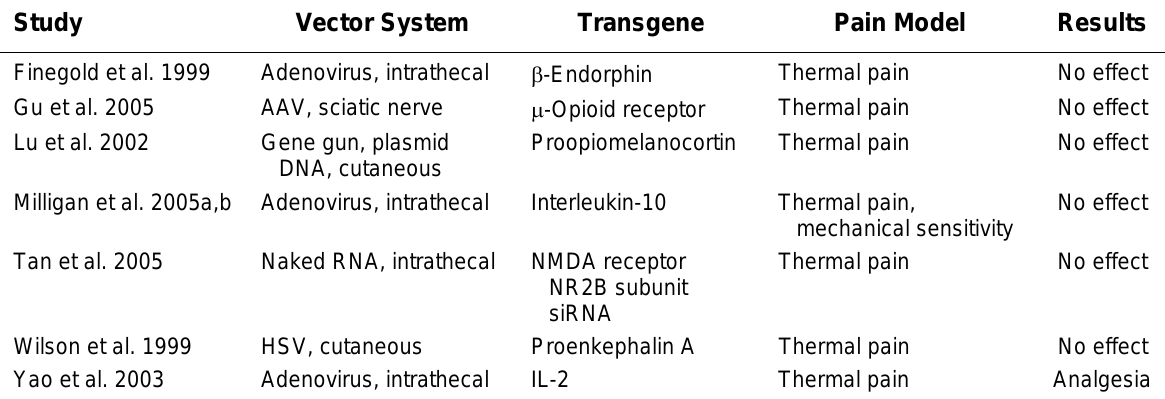
Effect of Gene Therapy on Baseline Thermal Pain and Mechanical Sensitivity in Rodents Study Vector System Transgene Pain Model